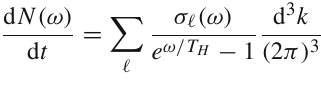
Fig. 3 σ abs / A H as a function of ω for two different regimes regarding (solid black line), ξ = 0 . 16 (dashed blue line), and ξ = 0 . 17 (dotted- dashed red line). In all four figures we fix r H = 2 and η = 0 . 25. In the non-minimal coupling: (1) when 0 ≤ ξ < ξ c (left) and (2) when ξ ≥ ξ σ / A ξ = 0 . 04 c (right). Left panel: H versus frequency for abs (solid black line), ξ = 0 . 08 (dashed blue line), and ξ = 0 . 12 (dotted- dashed red line). Right panel: σ abs / A H versus frequency for ξ = 0 . 15